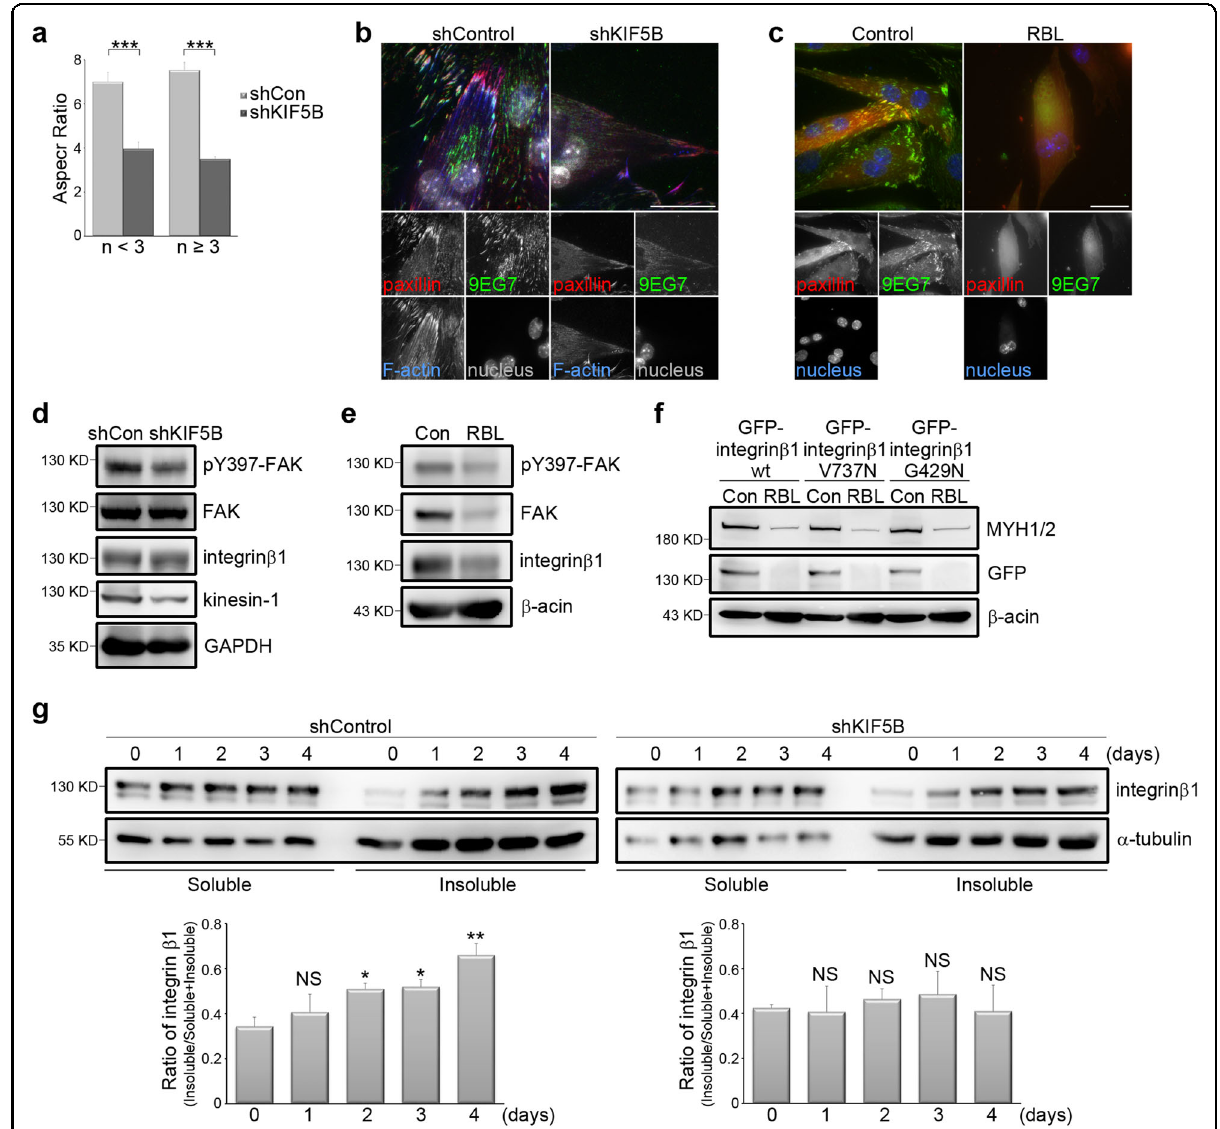
Fig. 4 Kinesin-1 regulates integrin β 1 activation and myotube morphology. a Effects of kinesin-1 expression on morphological changes of myotubes. C2C12 cells expressing non-silenced (shCon) or Kinesin-1-silenced (shKIF5B) shRNAs were treated with differentiation medium for 5 days and immunostained for MYH1/2 and DAPI. The MYH1/2 + cells were grouped based on the number ( n ) of nucleus in order to calculate the aspect ratio, namely the ratio of cell ’ s longest length to the cell ’ s shortest length. Data are mean ± s.e.m (shCon with <3 nuclei, n = 68 MYH1/2 + cells; shCon with ≥ 3 nuclei, n = 45 MYH1/2 + cells; shKIF5B with <3 nuclei, n = 168 MYH1/2 + cells; shKIF5B with ≥ 3 nuclei, n = 23 MYH1/2 + cells). *** p < 0.001. b TIRF microscopy images of immunolocalized paxillin (to visualize FAs; red), 9EG7 (to visualize activated integrin β 1; green), phalloidin (to visualize F- actin; blue), and DAPI (to visualize nucleus; gray) in non-silenced (shControl) and kinesin-1-silenced (shKIF5B) C2C12 cells treated with differentiation medium for 5 days. Scale bar, 30 μ m. c TIRF microscopy images of immunolocalized paxillin (to visualize FAs; red), 9EG7 (to visualize activated integrin β 1; green), and DAPI (to visualize nucleus; blue) in C2C12 cells, treated with differentiation medium containing DMSO (Control) or 40 µM RBL for 5 days. Scale bar, 30 μ m. d Western blot analysis of cell lysates obtained from non-silenced (shCon) and kinesin-1-silenced (shKIF5B) C2C12 cells, treated with differentiation medium for 3 days, using pY397-FAK, FAK, kinesin-1, integrin β 1, and GAPDH antibodies. e Western blot analysis of cell lysates obtained from C2C12 cells treated with differentiation medium containing DMSO (Con) or 40 µM RBL for 3 days, using pY397-FAK, FAK, integrin β 1, and β -actin antibodies. f Western blot analysis of cell lysates obtained from C2C12 cells expressing GFP-integrin β 1 wt, GFP-integrin β 1 V737N, or GFP-integrin β 1 G429N, treated with differentiation medium containing DMSO (Con) or 40 µM RBL for 3 days, using MYH1/2, GFP, and β -actin antibodies. g Top: pellets (polymerized microtubule-containing fractions; insoluble) and supernatants (free tubulin fractions; soluble) from non-silenced (shControl) and kinesin-1-silenced (shKIF5B) C2C12 cells treated with differentiation medium for 0, 1, 2, 3, or 4 days were fractionated and then analyzed by western blotting using antibodies against integrin β 1 and α -tubulin. Bottom: ratio of integrin β 1 in the polymerized microtubule-containing fractions (pellet; insoluble): total (insoluble + soluble fractions) as determined by western blotting ( n = 4 independent experiments). Data are mean ± s.e.m. * p < 0.05; ** p < 0.01; NS, no signi fi cance, all compared with 0